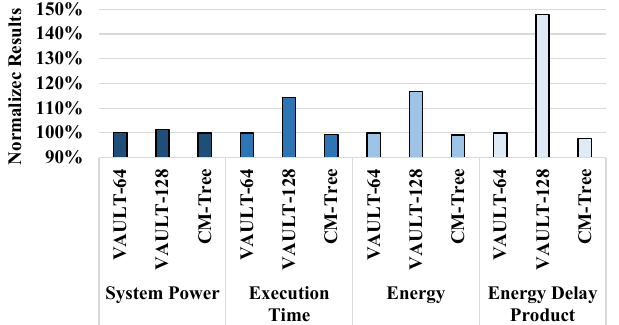
Figure 13. Power, execution time, energy, and EDP for VAULT-64, VAULT-128, and